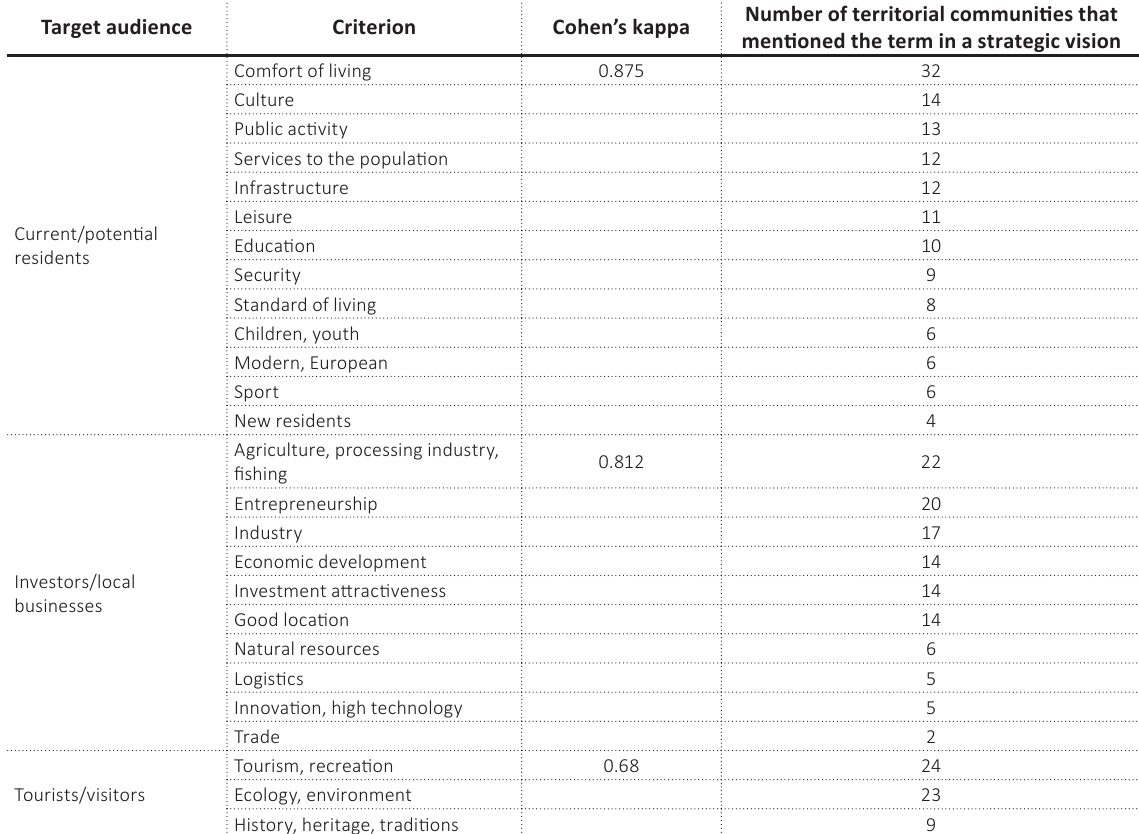
Table 4. List of positioning criteria per target audiences, % Target